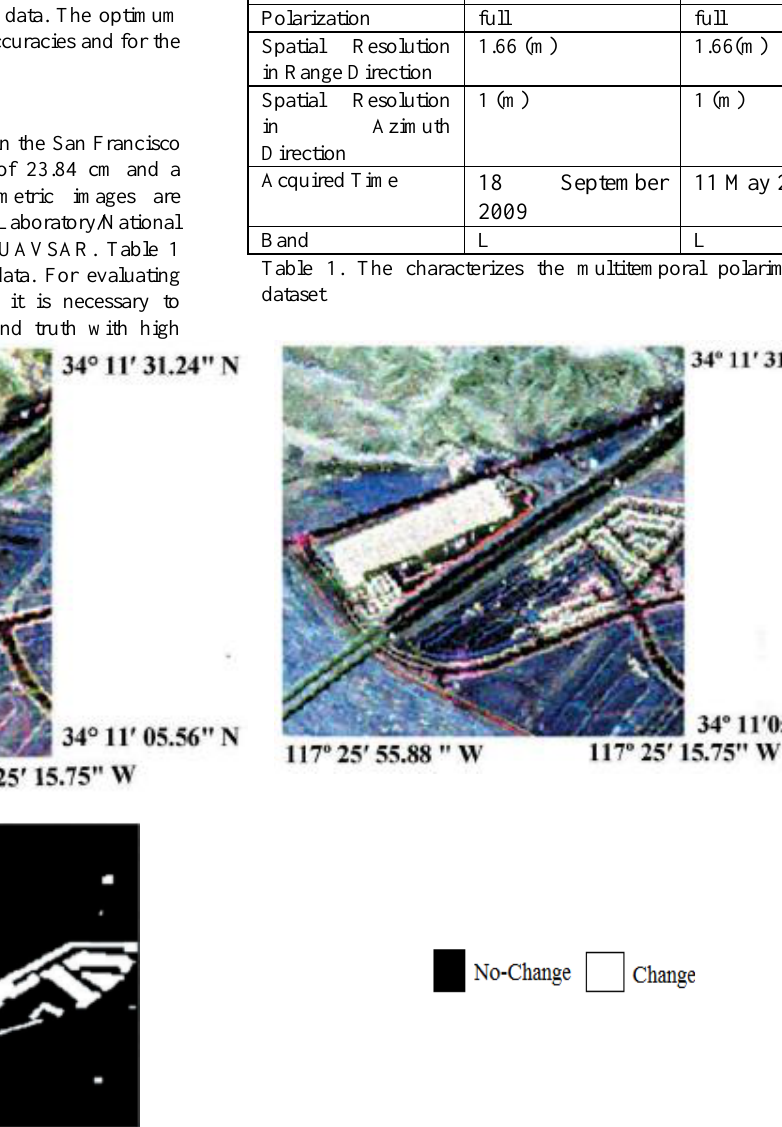
Figure 2. The (a) and (b) Pauli RGB composite of quad-pol UAVSAR images captured on 18 September 2009 11 May respectively, in San Francisco, United States of America, (c) ground truth, and (d)